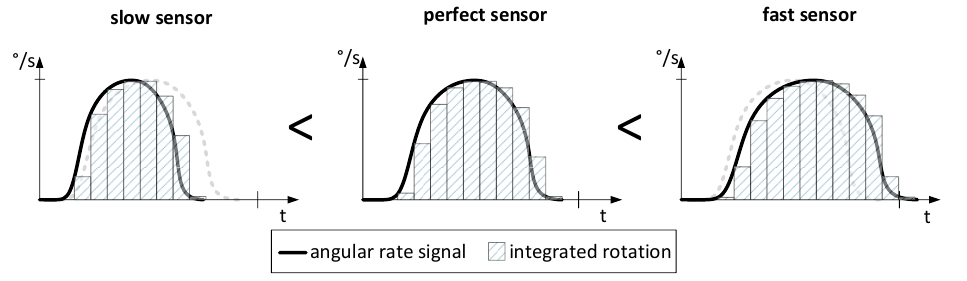
Figure 1. Exemplary illustration of the integration error due to relative sensor clock drift for a slow, perfect and fast running sensor clock,